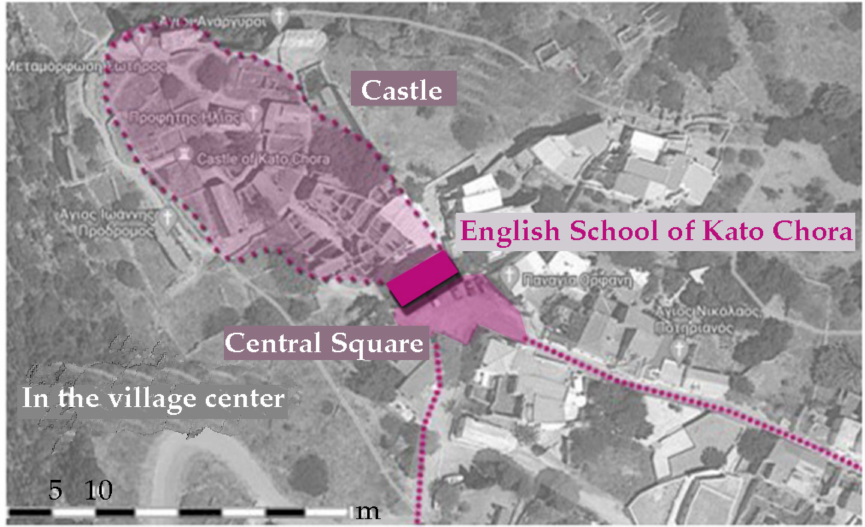
Figure 17. The location of the English School of Kato Chora in Kythera, modified after